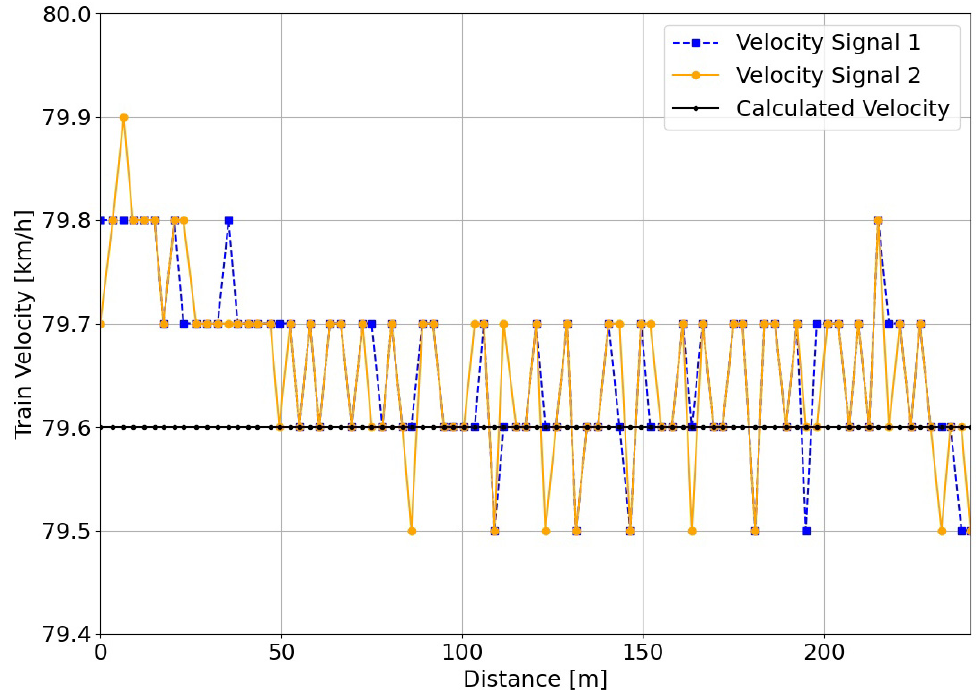
Figure 4. Comparison of measured velocity (signal from the on-board equipment of the train) and velocity based on the PCC calculation and the measured data of the optical system.